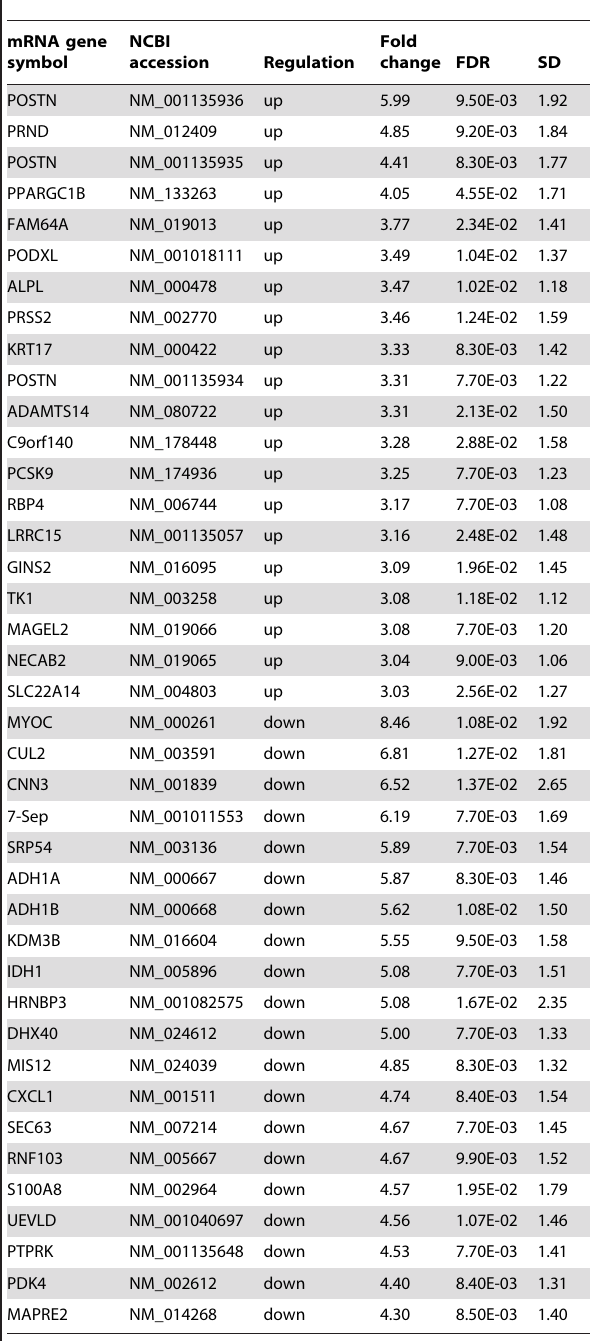
Table 4. Top 20 significantly differential expressed mRNAs from the microarray